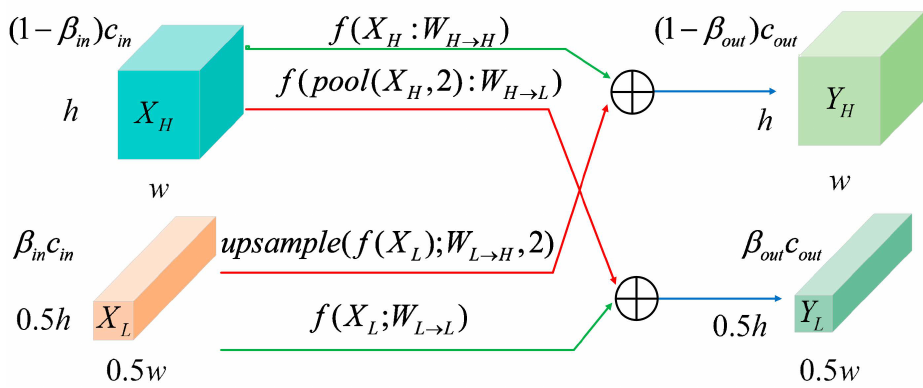
Figure 2. Schematic diagram of the three-dimensional octave convolution. The low-frequency part X L is upsampled to the original spatial or spectral resolution, and then convoluted with the high-frequency part X H . The low-frequency part is pooled to reduce the spatial or spectral resolution, and then connected with the low-frequency part for convolution. This not only enables the low-frequency information and high- frequency information in the tensor to be effectively processed but also enables effective inter-frequency communication. Let Y be the output tensor; the high-frequency and low- frequency output feature maps are denoted by Y = { Y H , Y L } , where Y H = Y H → H + Y L → H , Y L = Y L → L + Y H → L , and Y A → B represent the convolution update from group A to group B of the feature map, Y H → H and Y L → L represent the intra-frequency update, and Y H → L and Y L → H represent inter-frequency communication. The convolution kernel W is divided into two components W = { W H , W L } , which are convoluted with X H and X L , respectively. The two components of W can be further divided into two parts, W H = [ W H → H , W L → H ] and W L = [ W L → L , W H → L ] , as shown in Figure 3.